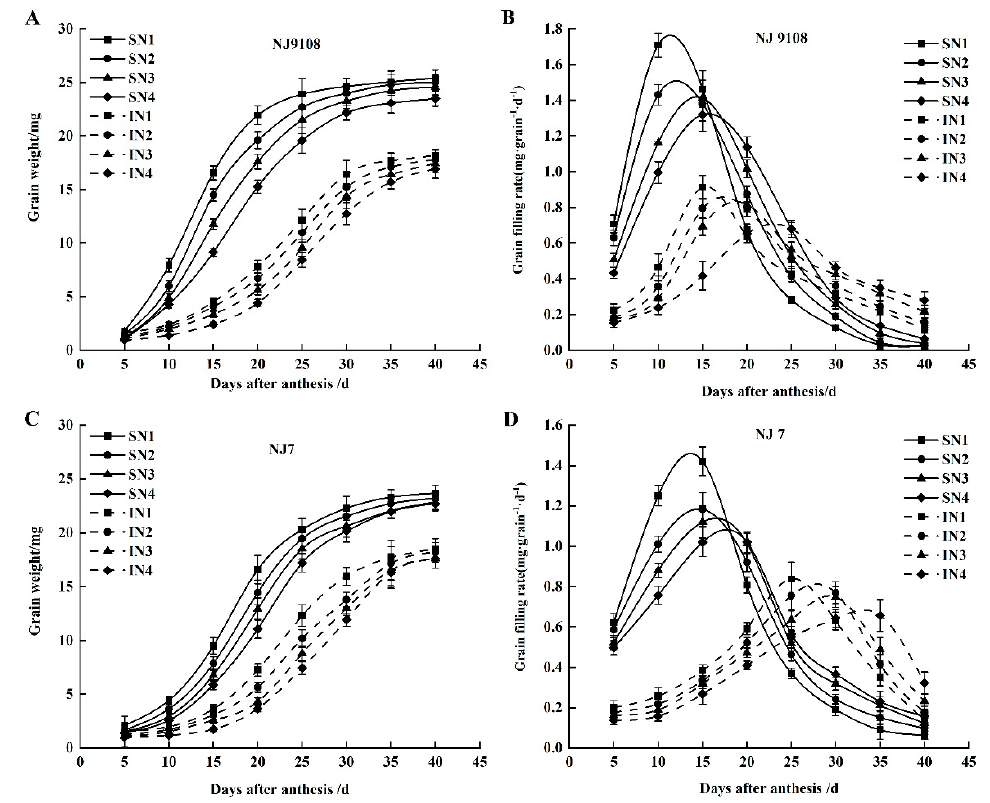
Figure 2. Grain weight ( A , C ) and grain filling rate ( B , D ) of superior (solid lines) and inferior (dotted lines) spikelets of rice. SN1 and IN1 represent the superior grain and inferior grain under N1 (0 kg N·ha − 1 ) condition, respectively. SN2 and IN2 represent the superior grain and inferior grain under N2 (195 kg N·ha − 1 ) condition, respectively. SN3 and IN3 represent the superior grain and inferior grain under N3 (270 kg N·ha − 1 ) condition, respectively. SN4 and IN4 represent the superior grain and inferior grain under N4 (345 kg N·ha − 1 ) condition, respectively.